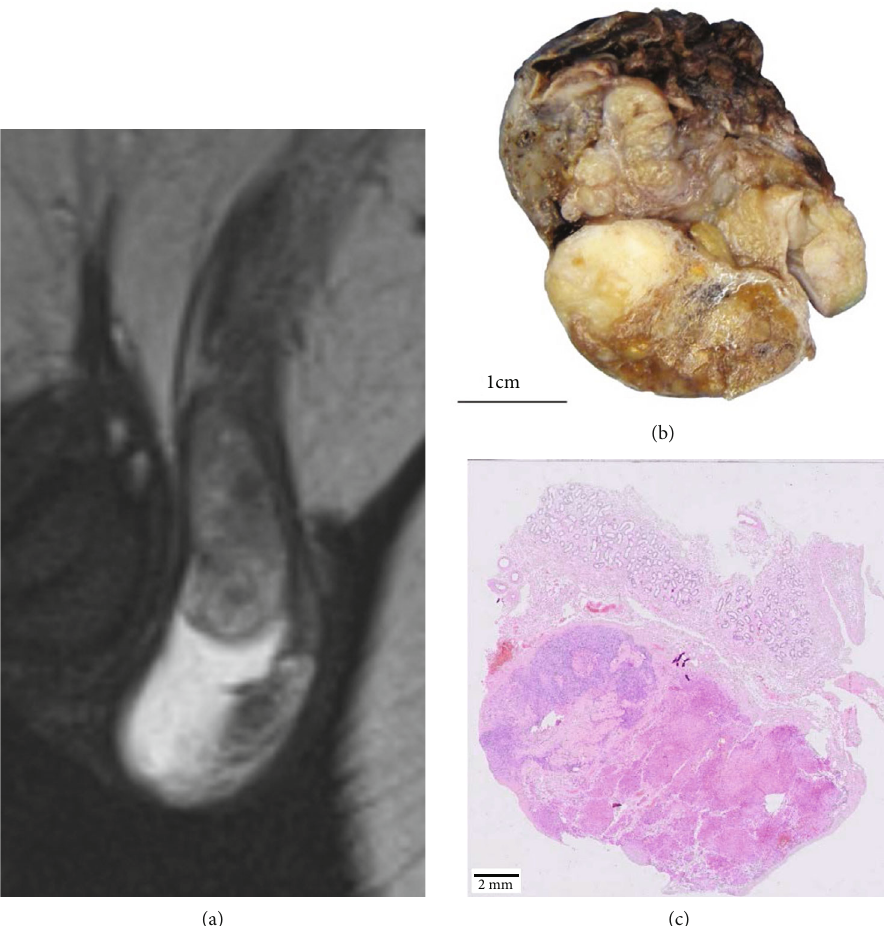
Figure 1: MRI-Scan showing a suspicious lesion of the remaining left testis (a). Cross-section of the specimen showing a biphasic lesion (b). A microscopic overview showing paratesticular tissue at the top, ovarian tissue on the left side, and an eosinophilic tumor on the right side